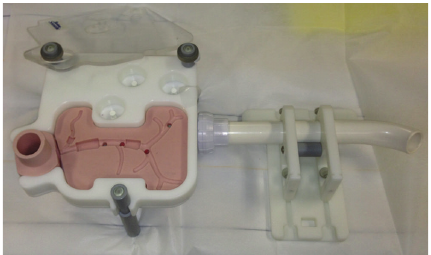
Figure 1: Endoscopic retrograde cholangiopancreatography trainer (the Chamberlain Group, LLC, Great Barrington, MA,